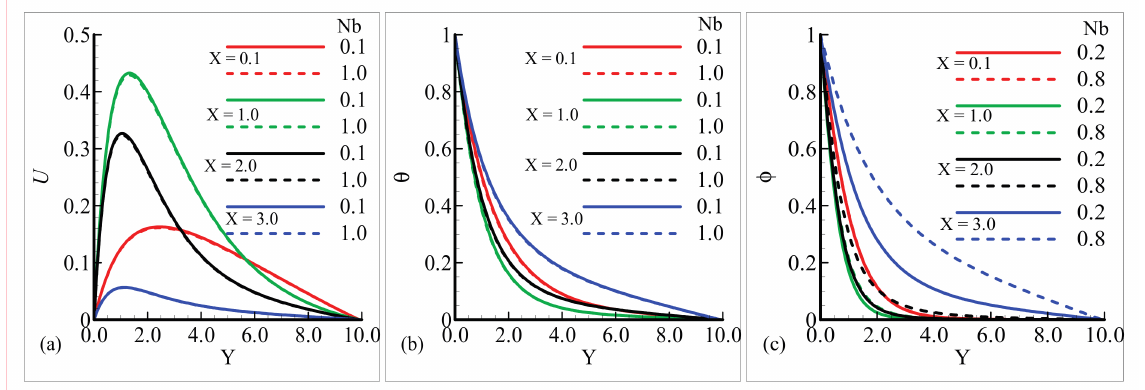
Figure 5. Physical e ff ects on quantities ( a ) U , ( b ) θ , and ( c ) ϕ versus Nb, when Nt = 0.02, Sc = 1.0, Pr = 7.0, M = 0.2, Q = 1.0.